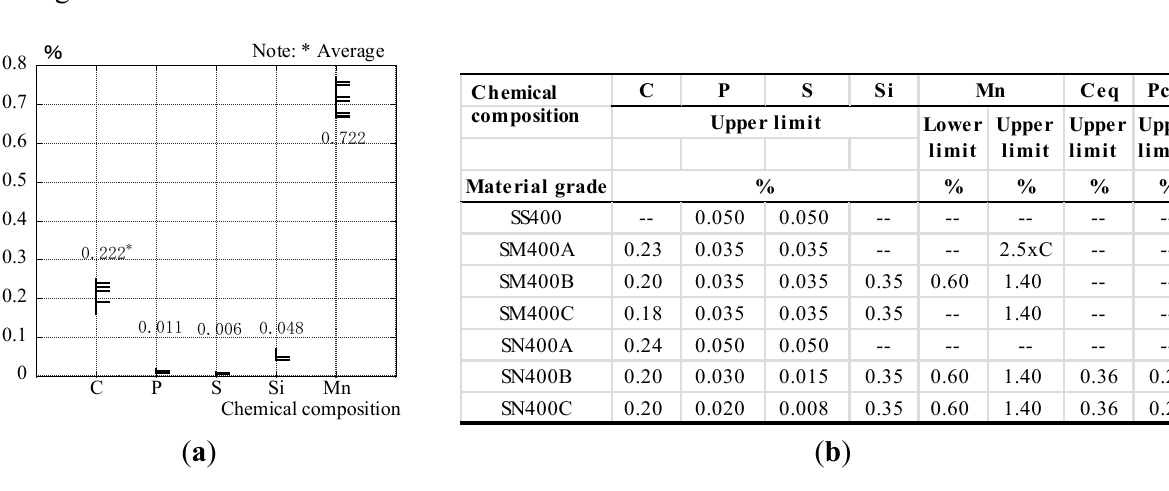
Figure 11. ( a ) Carbon equivalent (C eq ) and ( b ) weld crack sensitivity composition (P cm